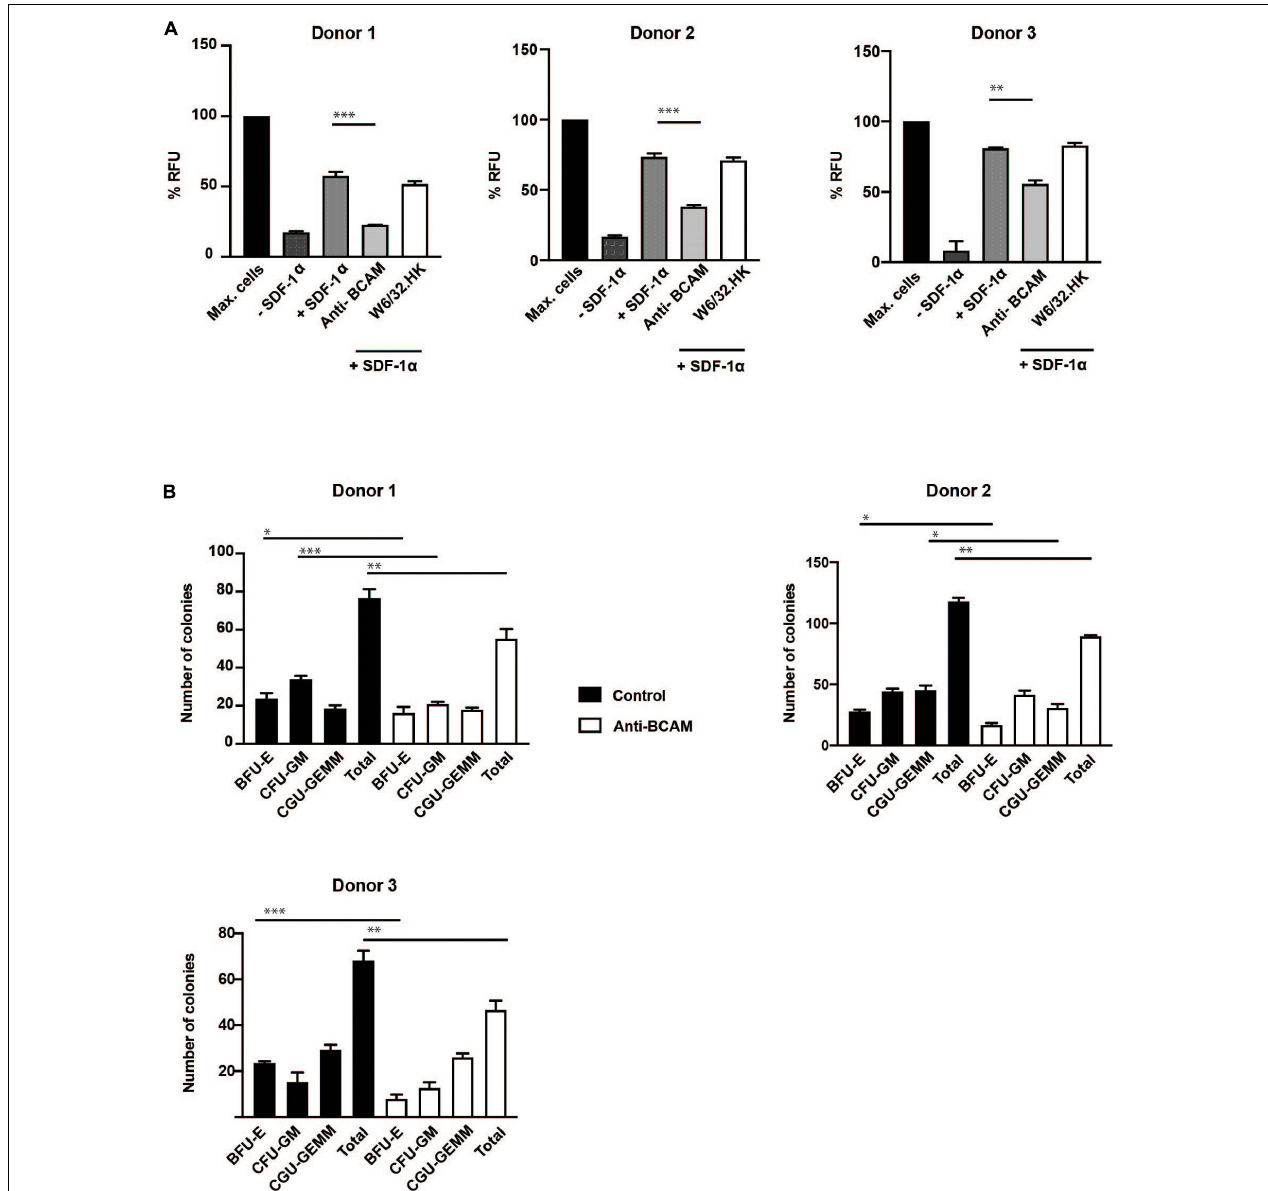
FIGURE 6 | BCAM/Lu regulates transmigration of CD34 + HSPC through endothelial barrier and regulates differentiation. (A) MACS-sorted CD34+ cells from three donors were allowed to migrate through an 8 µ m polycarbonate membrane pre-coated with a confluent layer of HUVEC. The adherent endothelial cell layer was either cultured without antibodies or treated with 10 µ g/ml of BCAM/Lu or W6/32.HK antibodies added to the endothelial cells. The lower chamber was filled with SFEM with or without 100 ng/ml SDF-1 α . The lower chamber without the cytokine was the negative control, whereas that containing SDF-1 α acted as positive control. The CD34+ cells were allowed to migrate through the membrane for 16 h. The number of migrated cells in the lower chamber was determined measuring the DNA content with the CyQuant. BCAM/Lu antibodies strongly inhibited the SDF-1 α induced transmigration in all three donors, whereas the control antibody W6/32.HK showed no inhibitory effect. (B) MACS-sorted CD34+ cells from three donors were pre-treated with antibodies against BCAM/Lu for 3 days, and 1000 cells were then plated on methylcellulose. The colonies were scored at day 14. The treatment with antibodies against BCAM/Lu induced lower number of colony formation. * p < 0.05; ** p < 0.005; *** p <